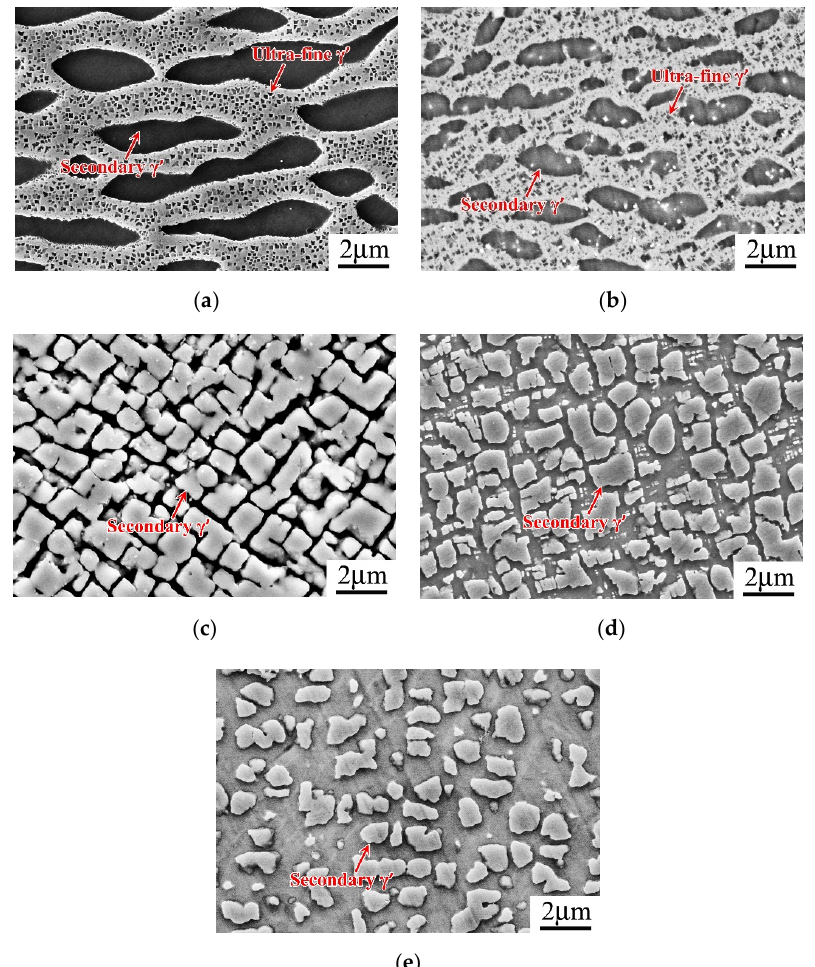
Figure 3. SEM-SE images of the γ ’ precipitates in the dendrite core regions at the longitudinal sections of creep specimens of K465 superalloy when creep under (900 °C/30 min–1100 °C/3 min)/50 MPa after 268 cycles ( a ) (900 °C/30 min–1150 °C/3 min)/50 MPa after 69 cycles ( b ) SEM-SE images of the γ ’ precipitates in the dendrite core regions of K465 superalloy after thermal exposure at 900 °C/1000 h ( c ) 1100 °C/3 min ( d ) and 1150 °C/3 min ( e ) followed by water cooling. Table 2. Area fraction of γ′ precipitates in the dendrite core regions of K465 superalloy after the standard solution treatment, during thermal cycling creep under different conditions and after heat treatment at 900–1150 °C.